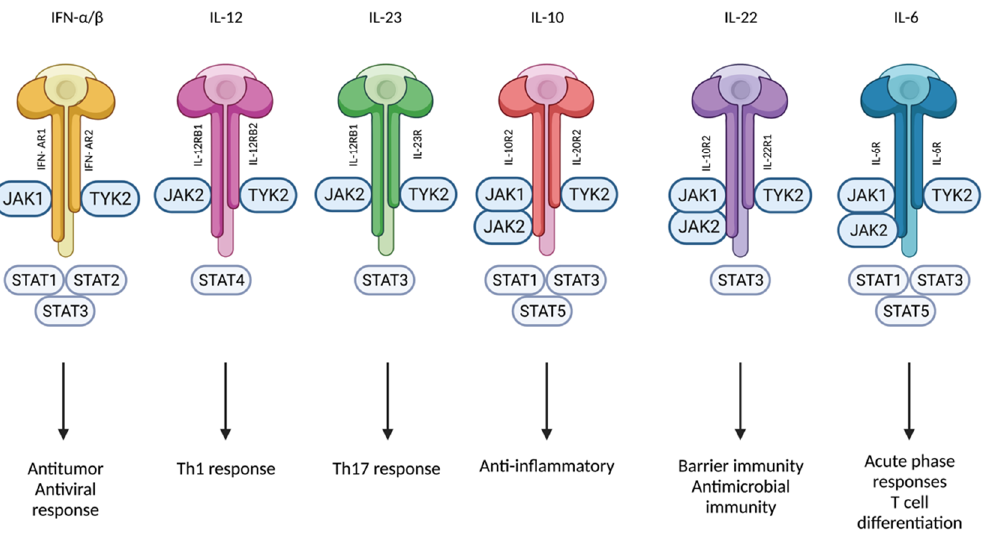
Figure 3. Tyk2 mediates signaling of IFN- α / β , IL-12, IL-23, IL-10, IL-22, and IL-6. Created with BioRender.com (accessed on 14 January 2023). Abbreviations: Tyk2, tyrosine kinase 2; IFN, interferon; IL, interleukin; Jak, Janus kinase; STAT, signal transducer and activator of transcription; Th, T-helper; R,